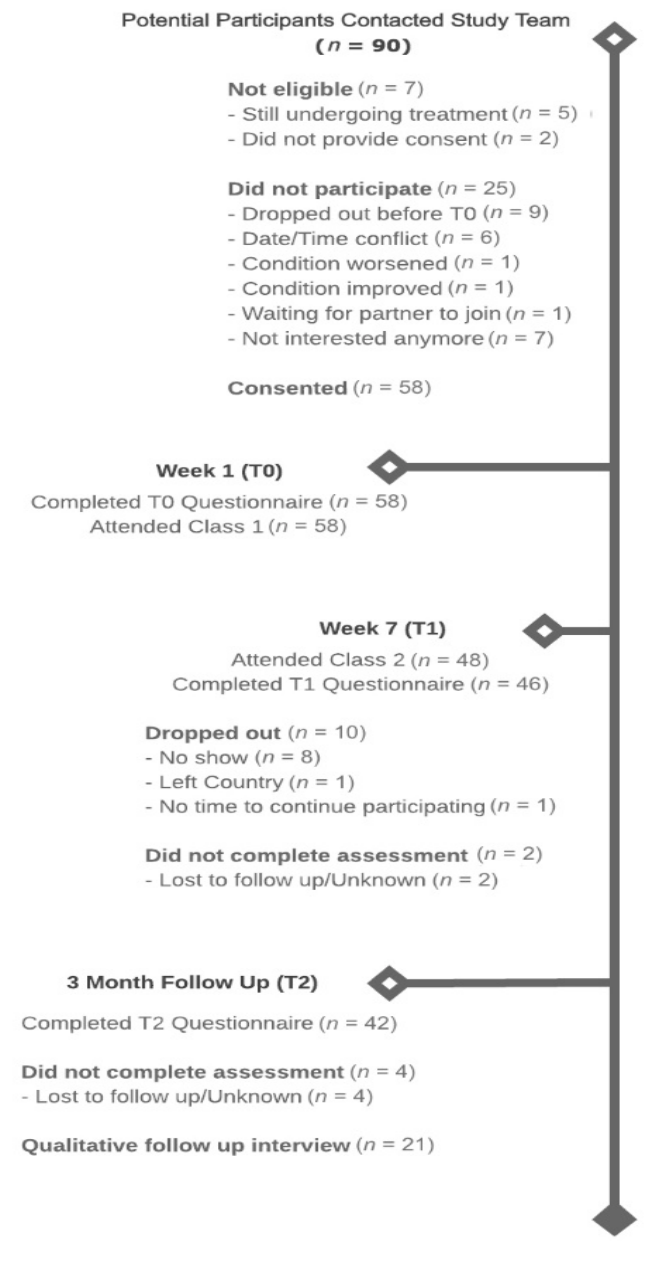
Figure 2. Study Flow Chart.